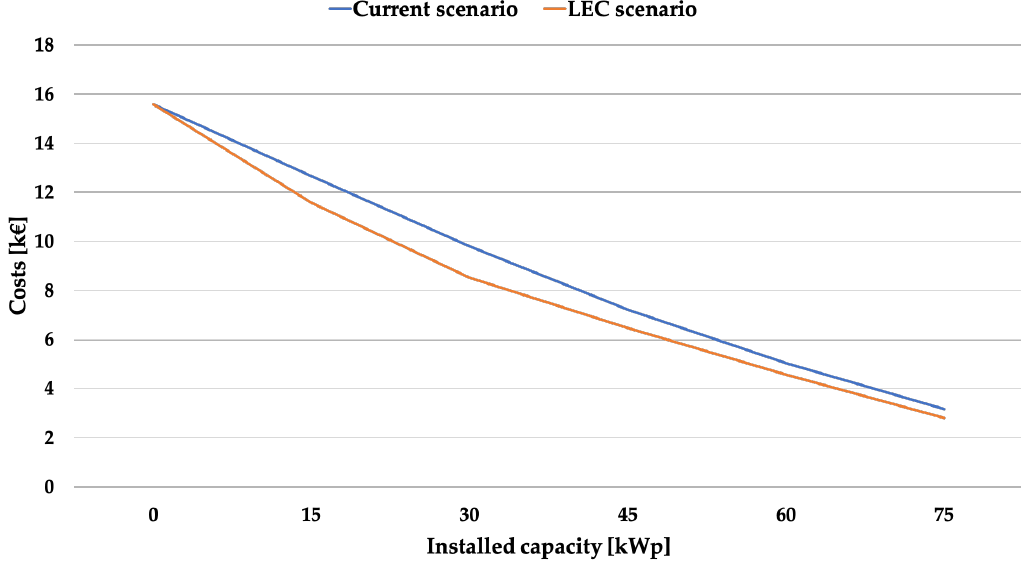
Figure 8. Cost analysis for no LEC and with LEC